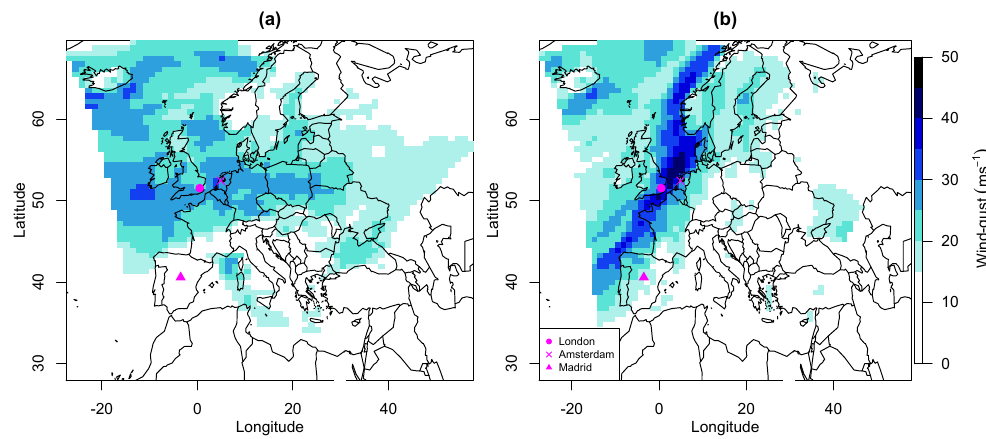
Figure 1. Hazard footprints for windstorms (a) Kyrill and (b) the Great Storm of October 1987, with the location of the cities of London, Amsterdam, and Madrid